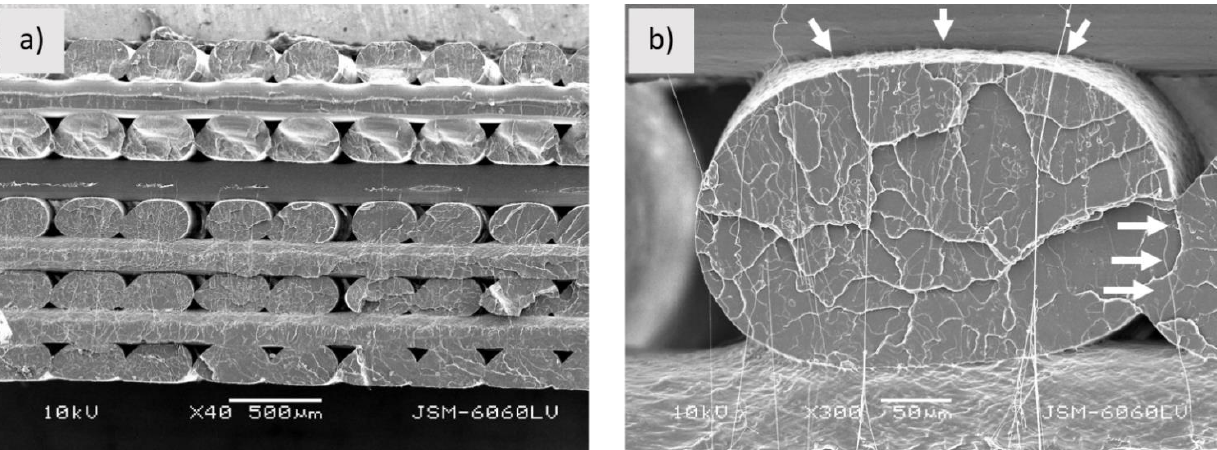
Figure 3. Sample PLA-Entwined_f; ( a ) fractured surface (mag. 40×), ( b ) gaps between matrix and hemp fibres (pointed by arrows) (mag. 1200×).